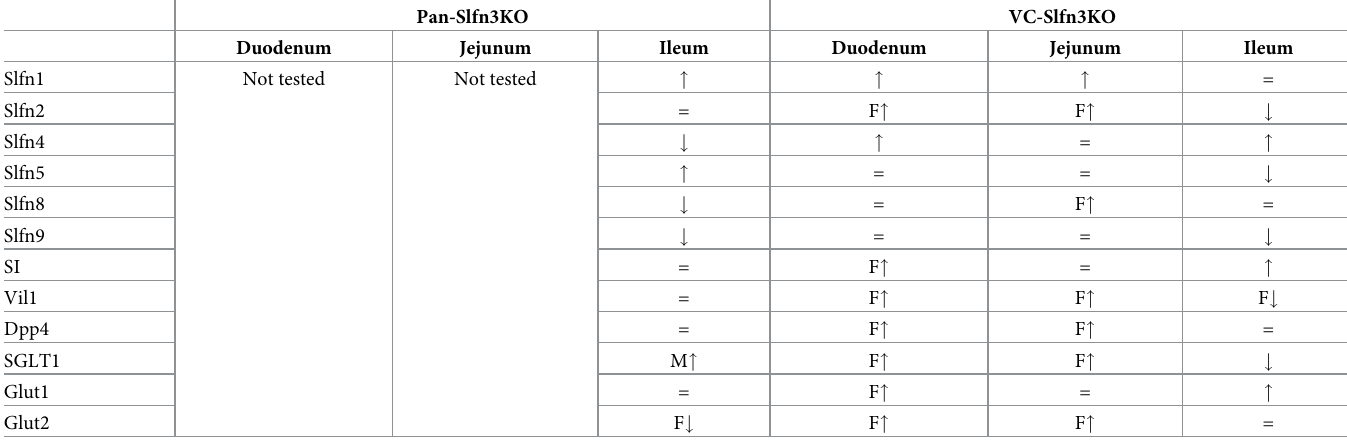
M: male, F: female, =: equal expression, " : increased expression, # : decreased